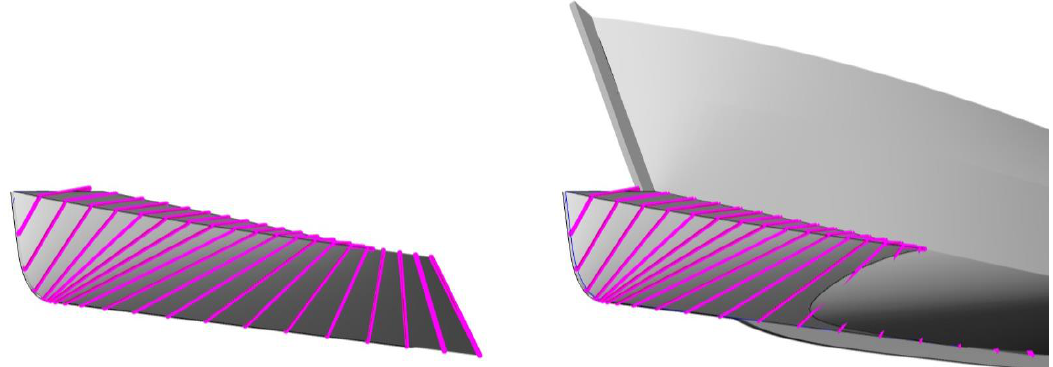
Figure 9. Rulings for the dihedral bow of example 1 (FAO2).